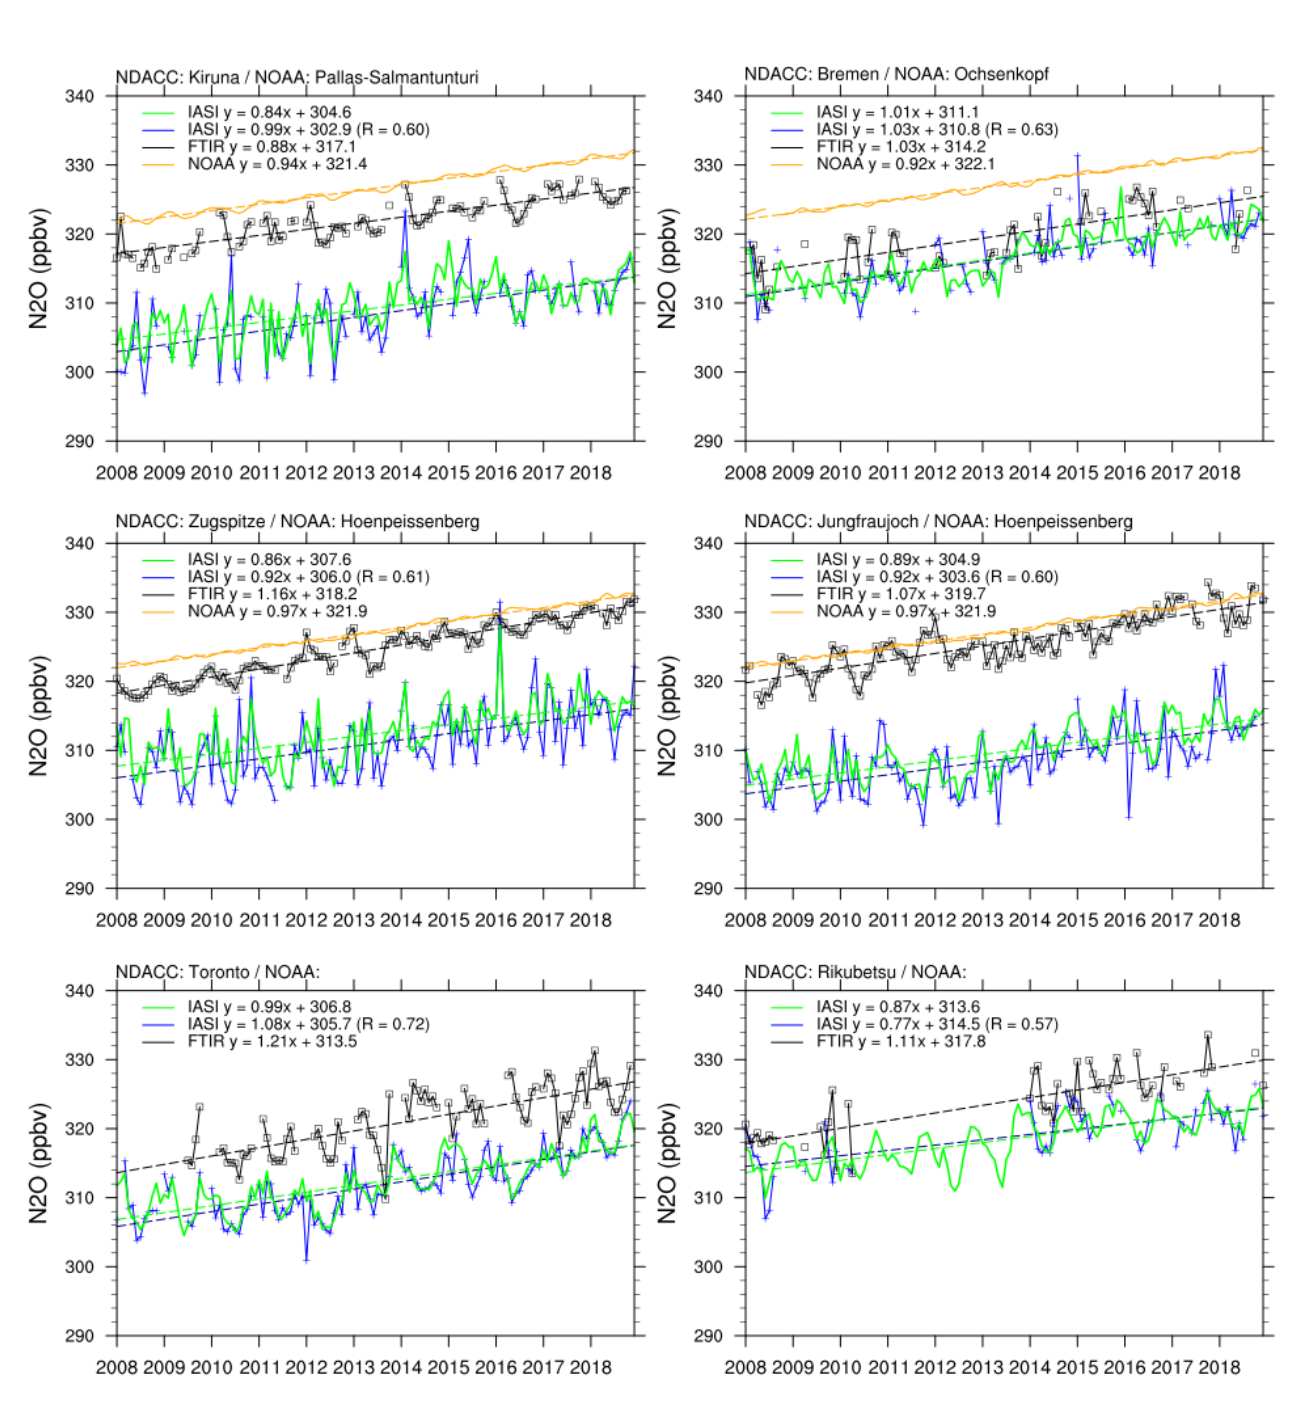
Figure 7. Time series of SOFRID (blue lines for data coincident with NDACC-FTIR data and green lines for all data) and NDACC-FTIR (black lines and squares) N 2 O MT VMR at 6 NDACC stations in the Northern Hemisphere (Kiruna, Bremen, Zugspitze, Jungfraujoch, Toronto, Rikubetsu). The NOAA-ESRL surface data from regional stations are also displayed. The solid lines represent the monthly means and the dashed lines the fit of a linear